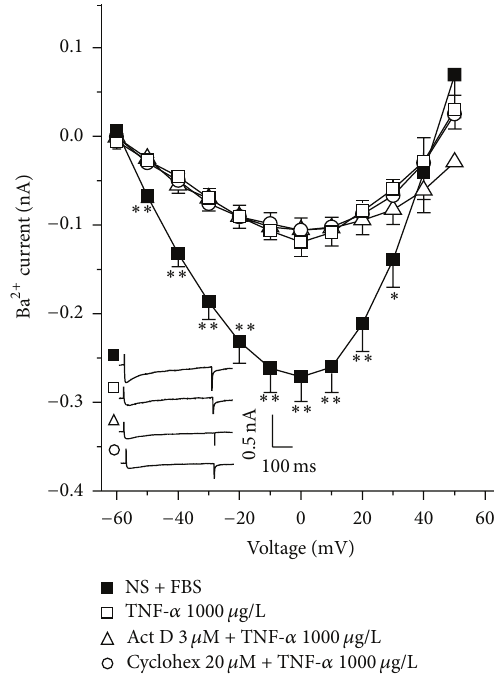
Figure 4: The Ba 2+ current reduction induced by TNF- 𝛼 is not mediated by a synthetic pathway activation in guinea pig tracheal myocytes. Ba 2+ current evoked by step depolarization from − 60 to 50 mV in tracheal cells from nonsensitized guinea pigs added with fetal bovine serum (NS + FBS, 𝑛 = 7 ) were significantly diminished when myocytes were grown with TNF- 𝛼 ( 𝑛 = 7 ). Neither actinomycin D (Act D, 𝑛 = 6 ) nor cycloheximide (Cyclohex, 𝑛 = 9 ) addition during myocyte growth altered TNF- 𝛼 induced effect on the Ba 2+ current. Inset represents original recordings. ∗ 𝑝 < 0.05 , ∗∗ 𝑝 < 0.01 , when compared with TNF- 𝛼 group. Symbols represent mean ±